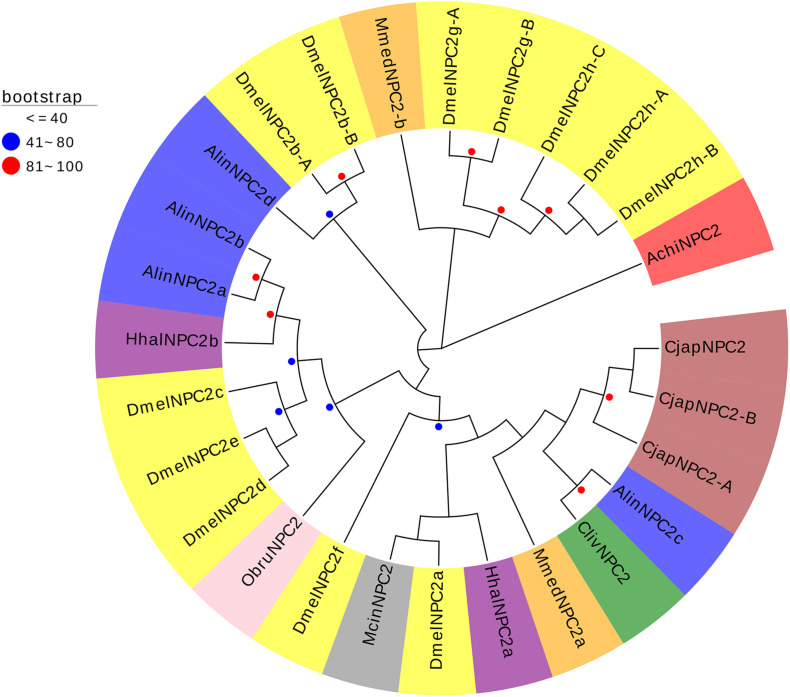
Phylogenetic analysis of the NPC2s (Niemann–Pick C2 proteins) from nine insect species: A. chinensis (Achi, red), D. melanogaster (Dmel, yellow), H. halys (Hhal, purple), C. lividipennis (Cliv, green), A. lineolatus (Alin, blue), M. cingulum (Mcin, gray), M. mediator (Mmed, orange), C. japonicus (Cjap, brown), and O. brumata (Obru, beige). Red circles mean bootstrap values are 81–100, blue circles mean bootstrap values are 41–80, and hide bootstrap values are less than 41.